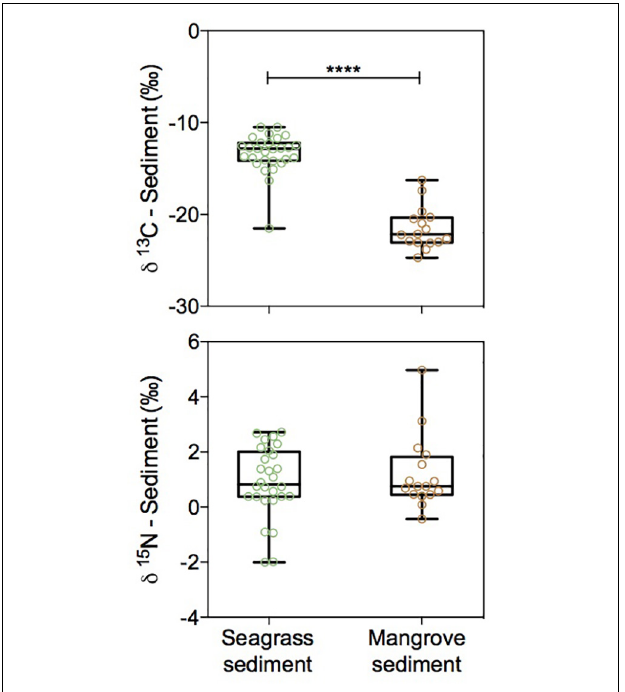
FIGURE 6 | Box plots of δ 13 C and δ 15 N for seagrass (green) and mangrove (brown) sediments showing all data points. Boxes extend from the 25 th to 75 th percentiles, lines inside boxes represent median values, and whiskers span from minimum to maximum values. Statistically significant differences are indicated by asterisks where ∗∗∗∗ indicates p <